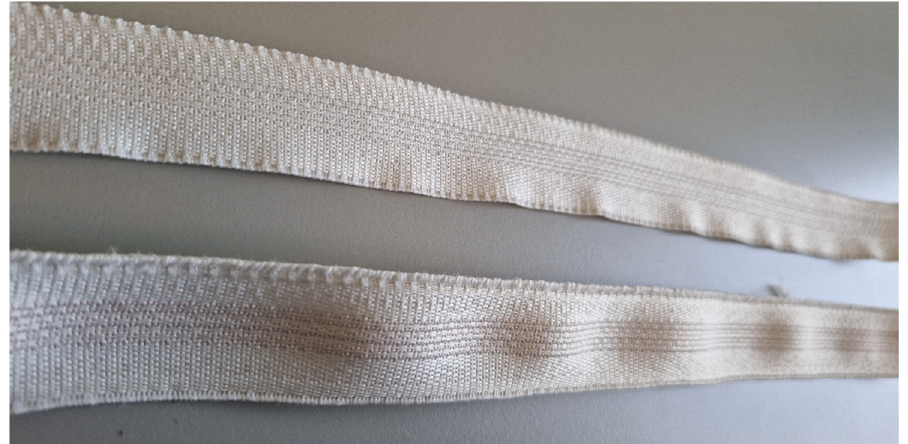
Figure 5. Top: Narrow fabric with 6 rows of Yarn 1. Bo tt om: Narrow fabric with 6 rows of Yarn 2. The best-performing samples were found in sample sets 2 and 4 with Yarn 2. Along